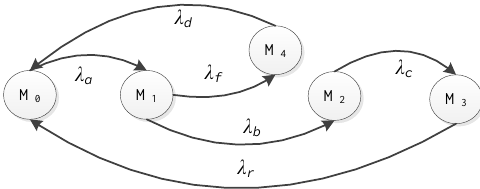
Figure 8. Defense Scenario I: the isomorphic model with the MC and the process of